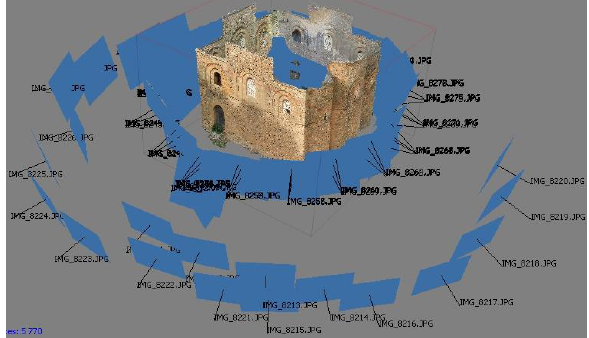
Figure 7. Photogrammetric reconstruction of the external environment using SLR camera images.